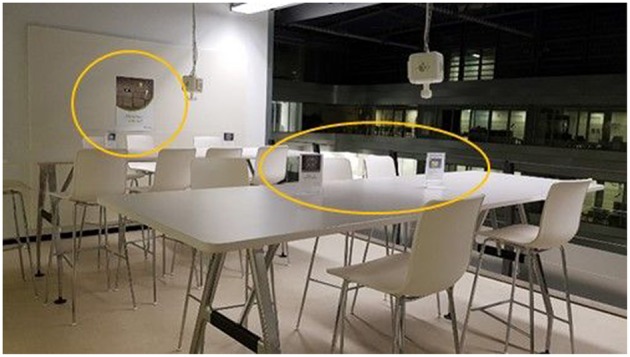
Sit-stand-desks in a study area with intervention poster and table plaques set up.